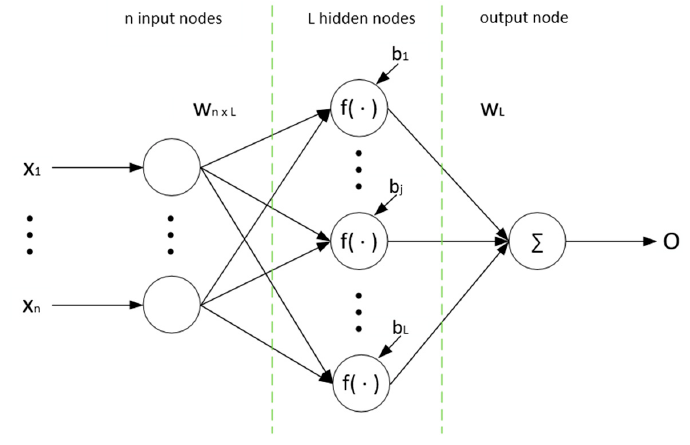
Figure 1. Structure of a single hidden layer and single output extreme learning machine ( ELM ).